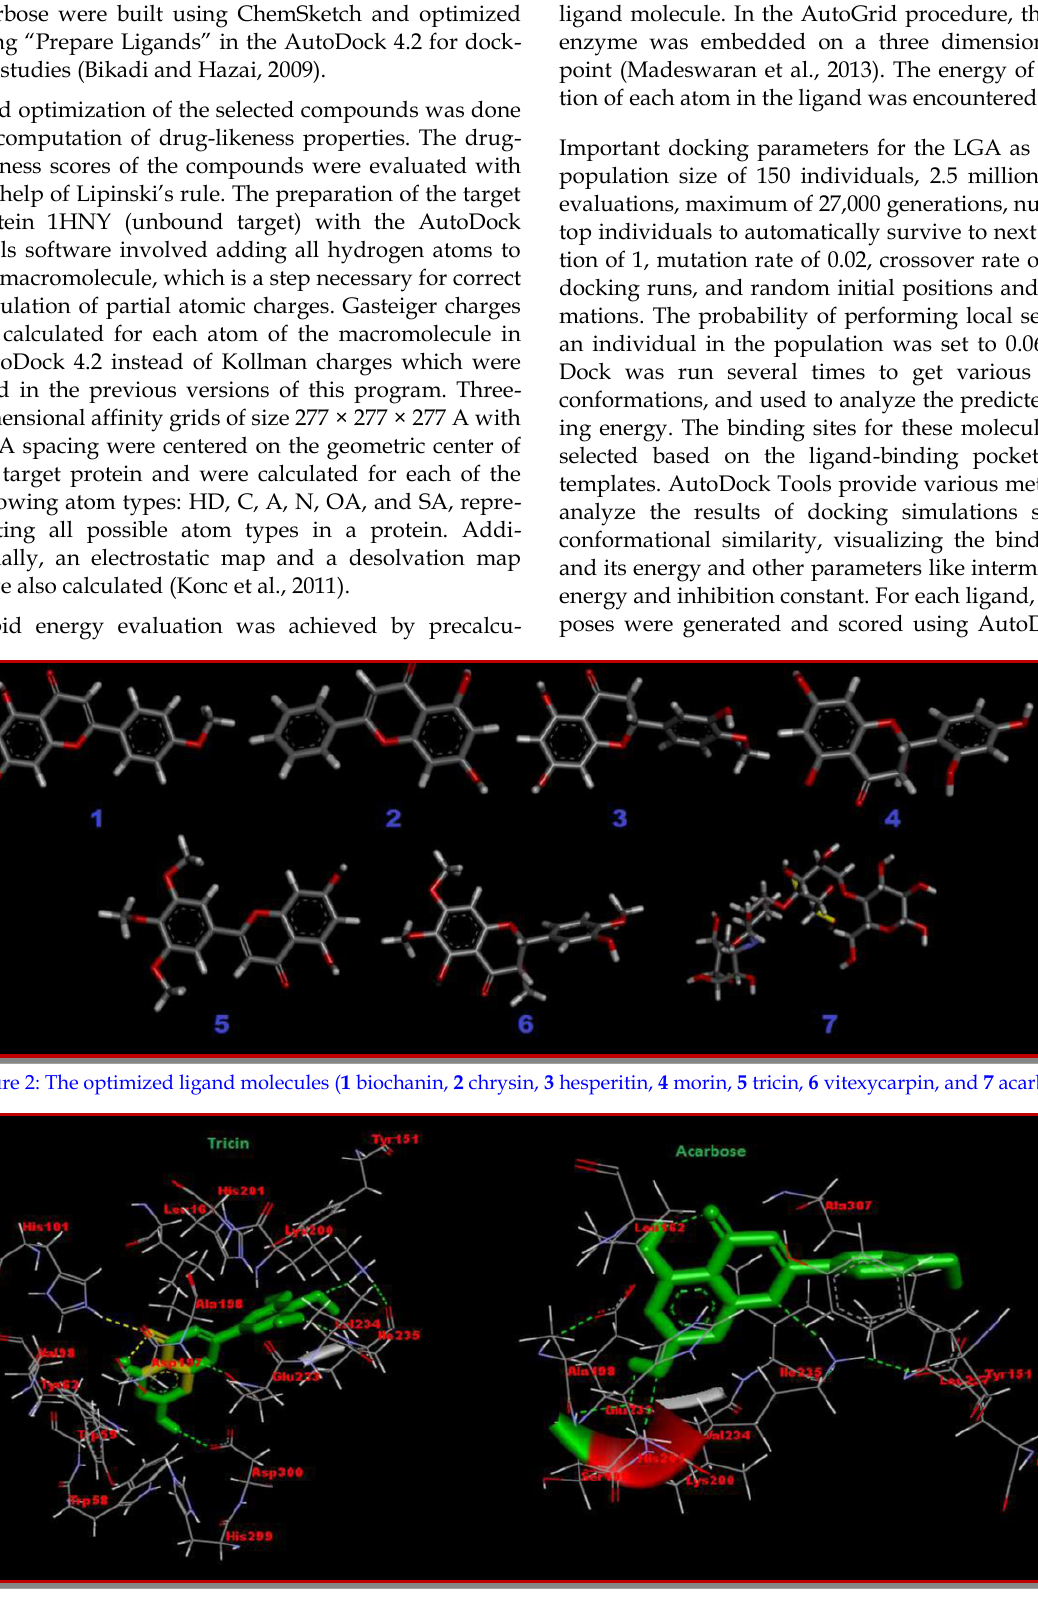
Figure 3: Docked pose of α-amylase enzyme (1HNY) with tricin and